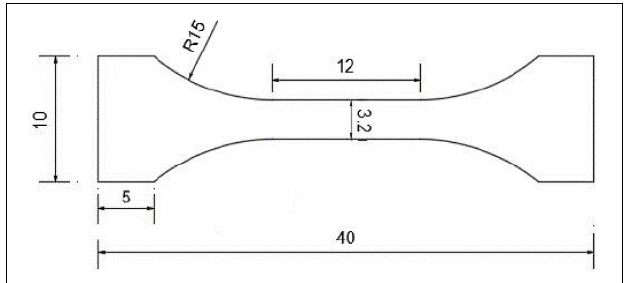
FIGURE 1 | The dimensions are used for tensile testing